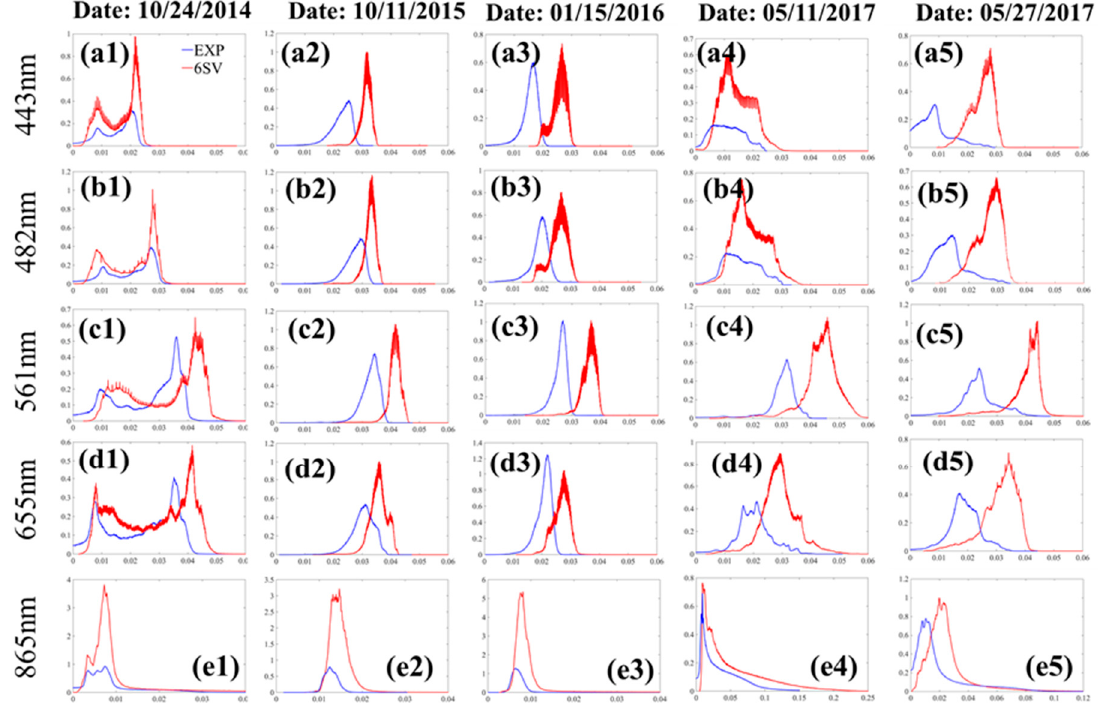
Figure 6. Frequency of R rs ( λ ) retrieved using EXP algorithm (blue line) and 6SV algorithm (red line)